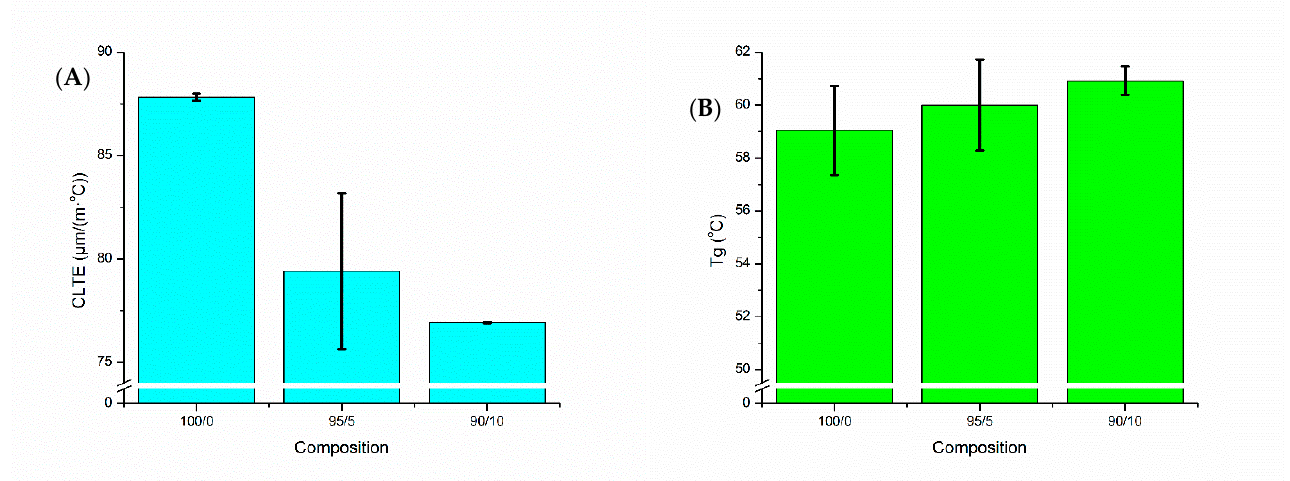
Figure 4. Thermomechanical analysis of the blend and composites: ( A ) coefficient of linear thermal expansion (CLTE) and ( B ) glass transition temperature (T g ) where injection molded samples were used. See Table 2 for nomenclature.